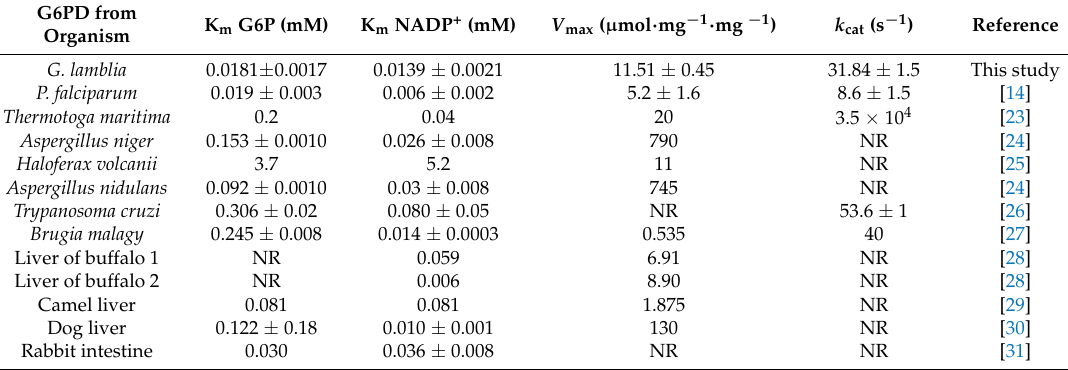
Table 2. Steady-state kinetic parameters of the G6PD::6PGL from G. lamblia and another G6PDs previously reported.